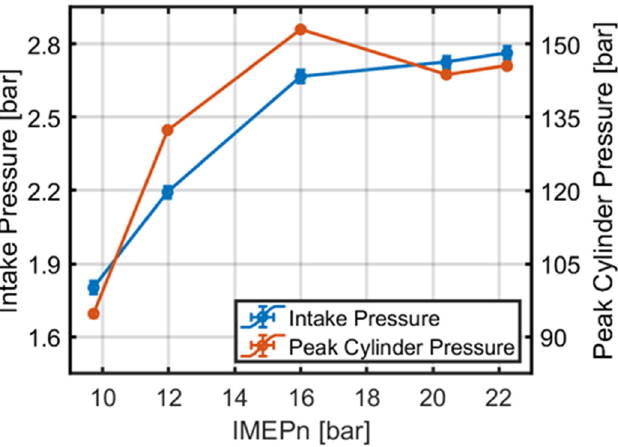
Figure 15. Intake pressure and peak cylinder pressure vs. net indicated mean effective pressure